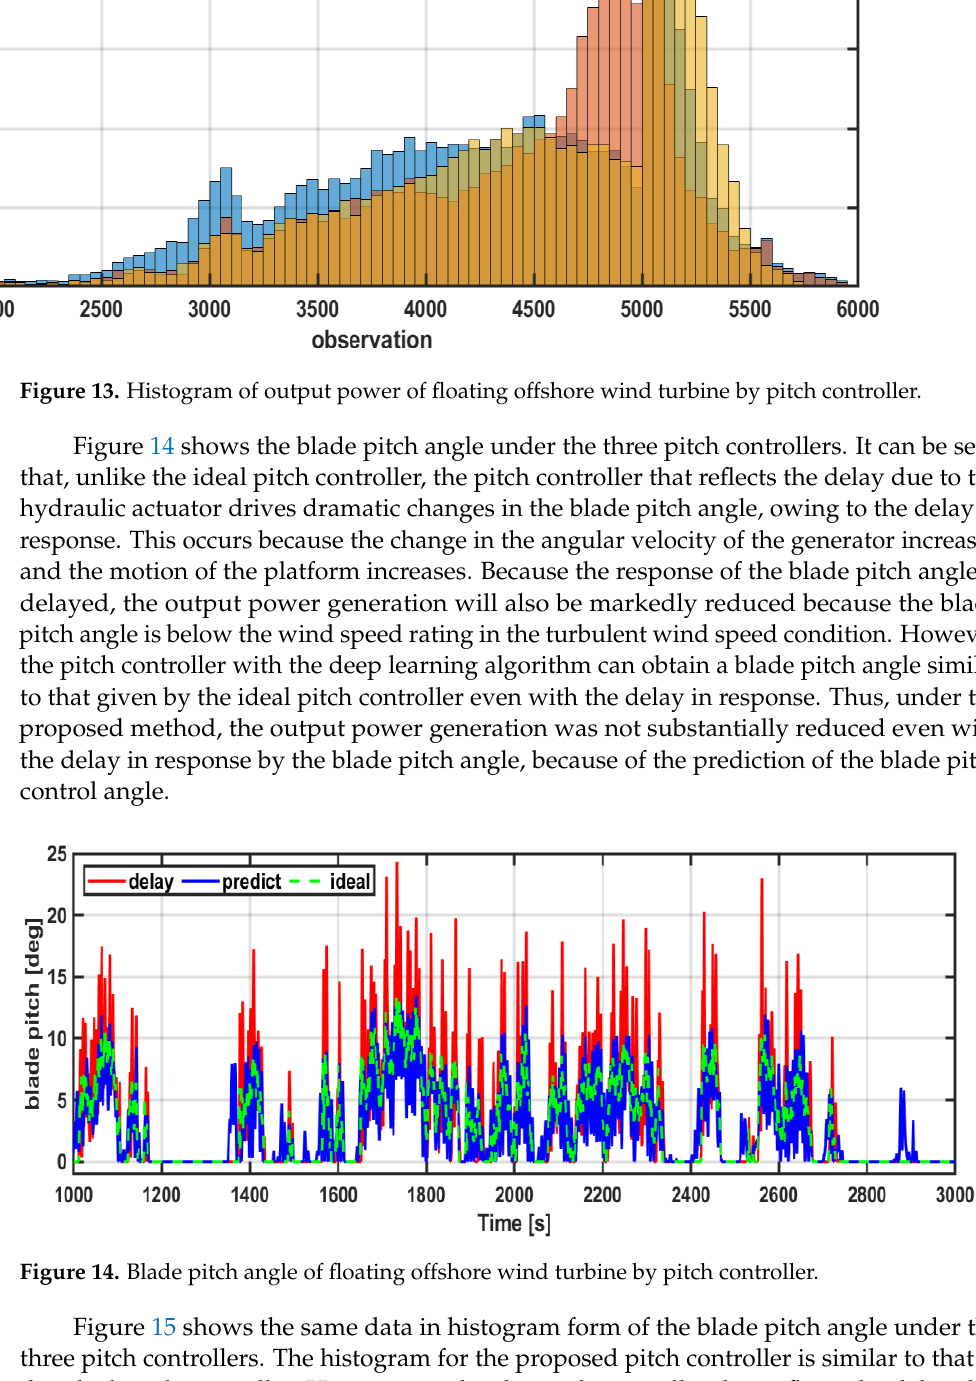
Figure 15. Histogram of blade pitch angle of floating offshore wind turbine by pitch controller. In addition to output power generation, the motion of the floating body is an im- portant concern for a floating offshore wind power system. Figure 16 shows the floating body pitch motion under the three pitch controllers. It can be seen that the pitch motion of the floating body is greater under the pitch controller that reflects the delay due to the hydraulic actuator than under the ideal pitch controller; this is because of the delay in response of the blade pitch angle. Under the proposed pitch controller, however, the pitch motion of the floating body is less than that under the ideal pitch controller. The histograms shown in Figure 17 confirm that the pitch controller that reflects the delayed response can substantially increase the pitch motion of the floating body, whereas the proposed pitch controller can reduce the pitch motion of the floating body. This demon-